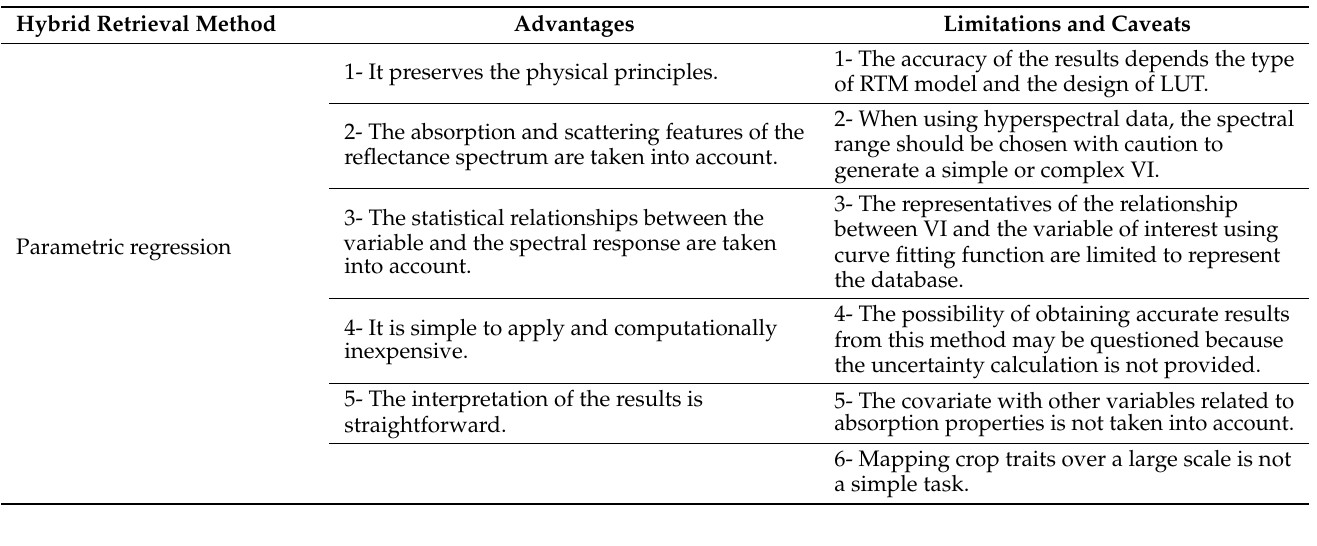
Table 1. Overview of the advantages and limitations and caveats of the parametric method.